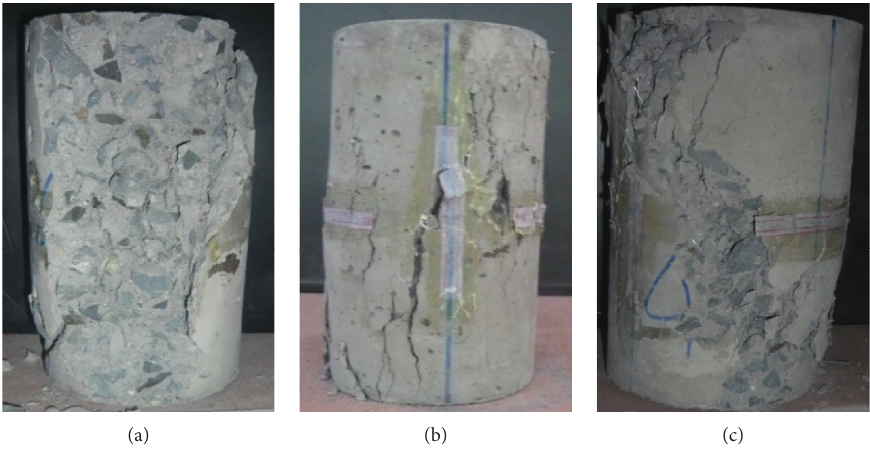
Figure 4: Typical failure diagram: (a) specimen a-n-1; (b) specimen b-p-1; (c) specimen